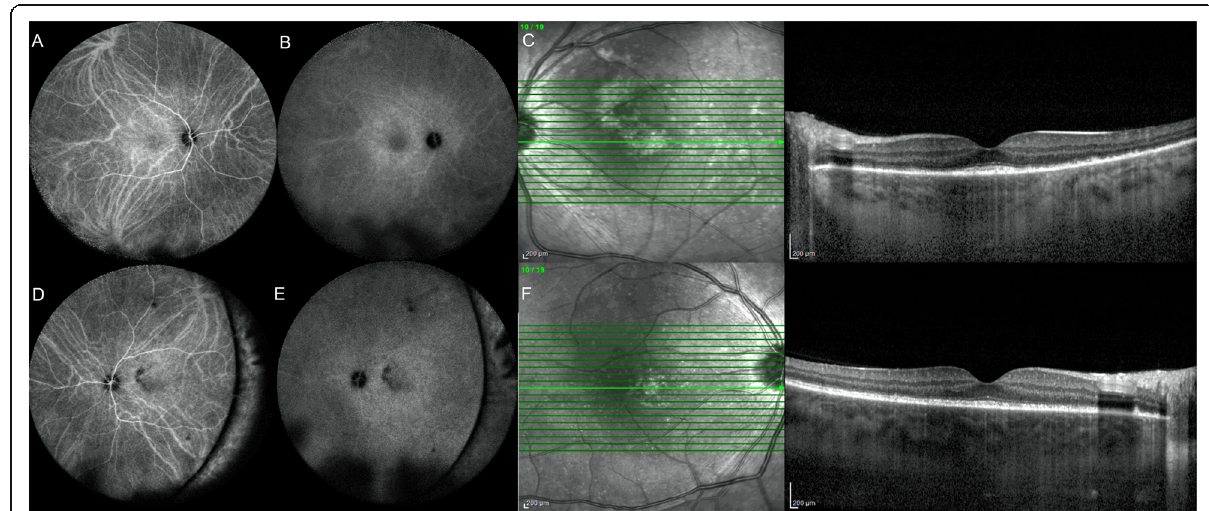
Fig. 2 Indocyanine green angiography of the right ( a , b ) and the left eye ( d , e ) at the third month disclosed only a few hypofluorescent dark dots (HDD) in both eyes and mild background hyperflorescence at the posterior pole indicating a response to treatment with mild subclinical inflammation of choroidal stroma. Enhanced depth imaging optical coherent tomography of the right ( c ) and left ( f ) eyes at 3 months follow-up showed complete response with resolution of serous retinal detachment and decreased choroidal thickening and